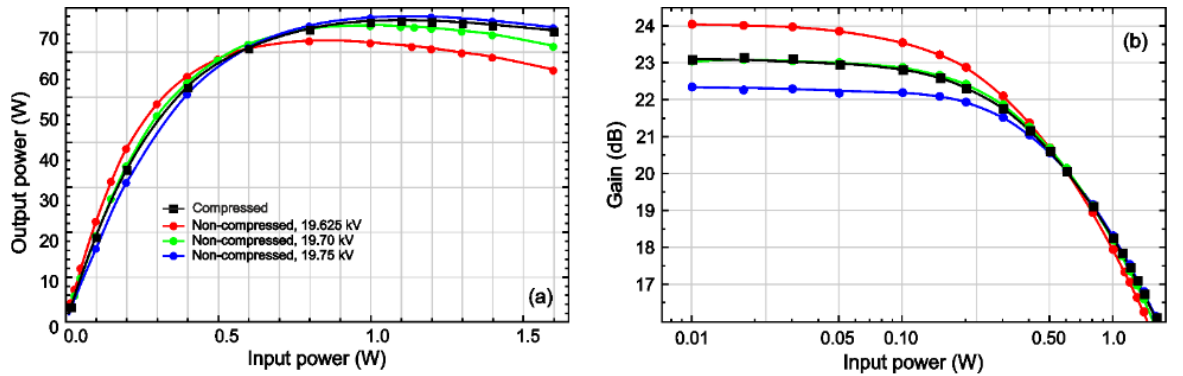
Figure 8. Saturated output power and corresponding input power versus frequency. Figure 9 shows the output power and gain versus the input power computed at 0.22 THz frequency. The small-signal gain and saturated power are 23 dB and 66 W, respectively. Note that the increase of the interaction impedance allows a significant decrease of the tube length in comparison with our previous research [8–10] (25 mm instead of 40 mm) that will provide a reduction of size and weight of the MFS.